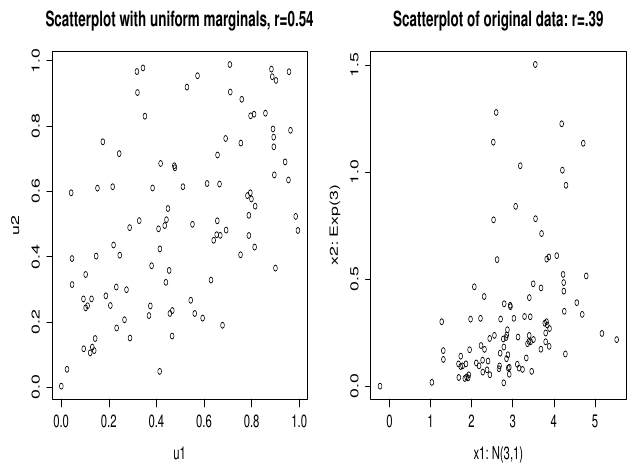
Figure 2 { Scatterplot of the simulated data and pseudo-data: X 1 (cid:24) Exp(3); X 2 (cid:24) N (3 , 1)